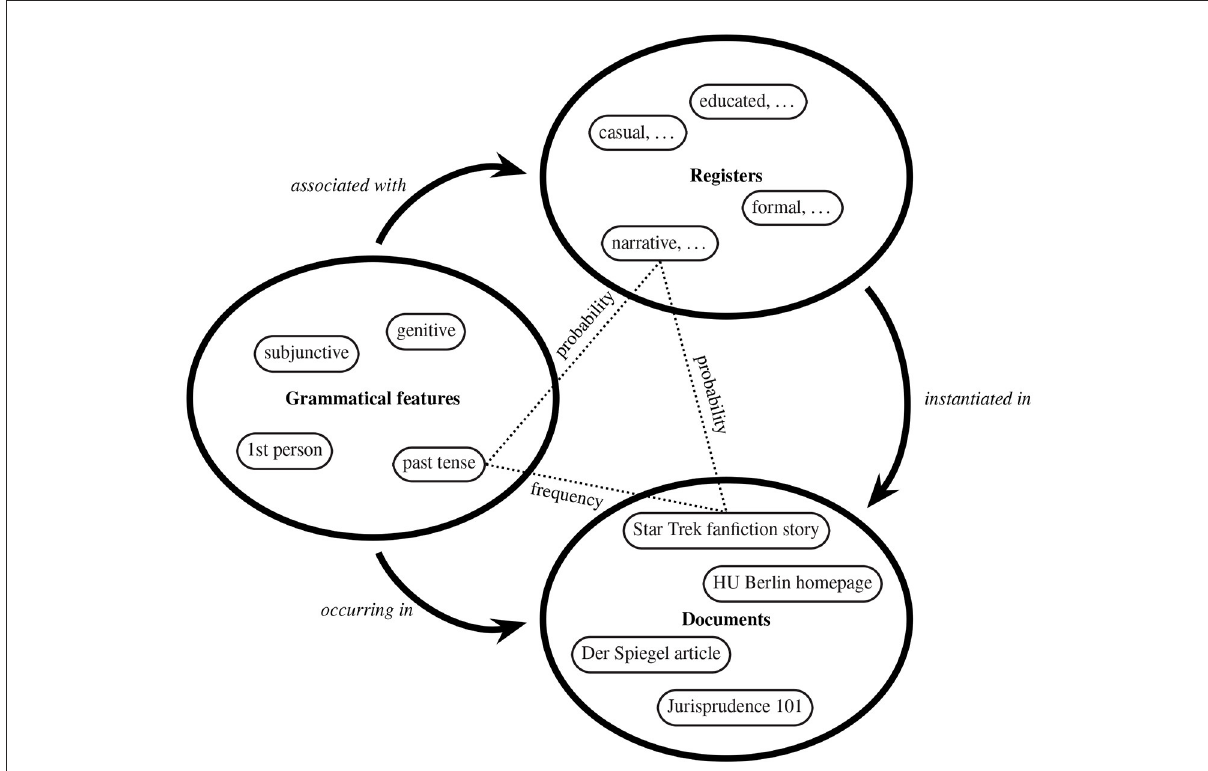
FIGURE2 Project A04: Illustration of a probabilistic model of registers, grammatical features, and documents by examples; probabilities and frequencies are defined between each pair of elements from the respective